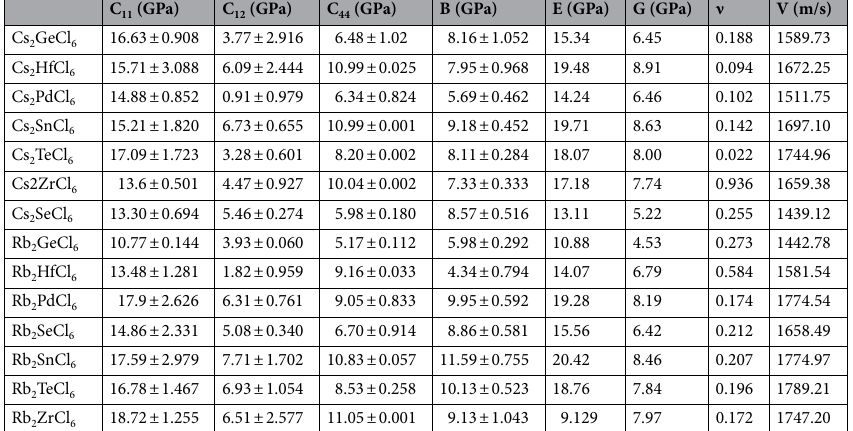
Table 3. Elastic Modulus of Chloride Inorganic